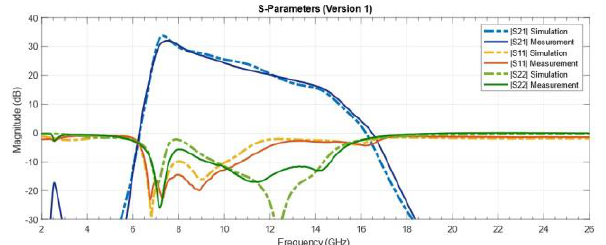
Figure 19: S parameter results of the LNA. Dashed line simulation and solid line measurement